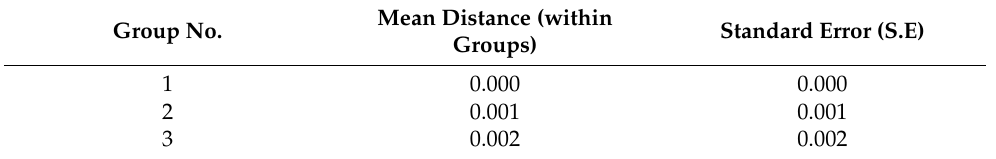
Figure 1. Genetic relatedness comparing isolates from animal ( ) and human ( ) samples with reference strains from different countries based on the concatenated sequences of the six house- keeping genes using neighbor-joining phylogenetic trees with bootstraps of 100. Table 2. Estimates of the average evolutionary divergence over sequence pairs within groups. Group No. Table 3. Estimates of the average evolutionary divergence over sequence pairs within groups on rrs genes. Group